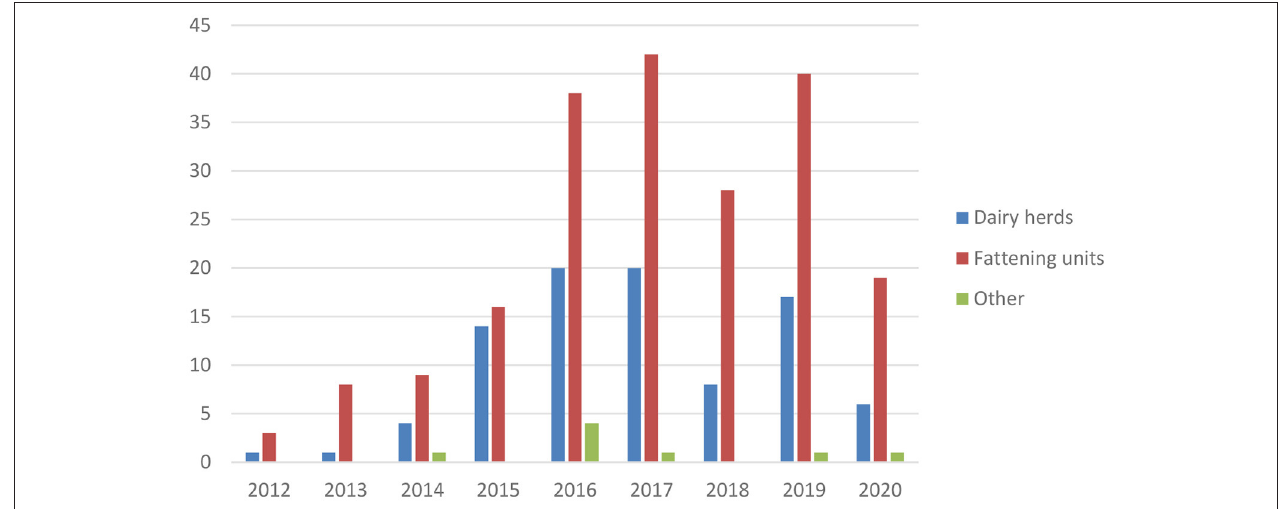
FIGURE 6 | Number of new M. bovis -infected cattle herds in Finland in 2012–2020. Fattening units include calf rearing and finishing